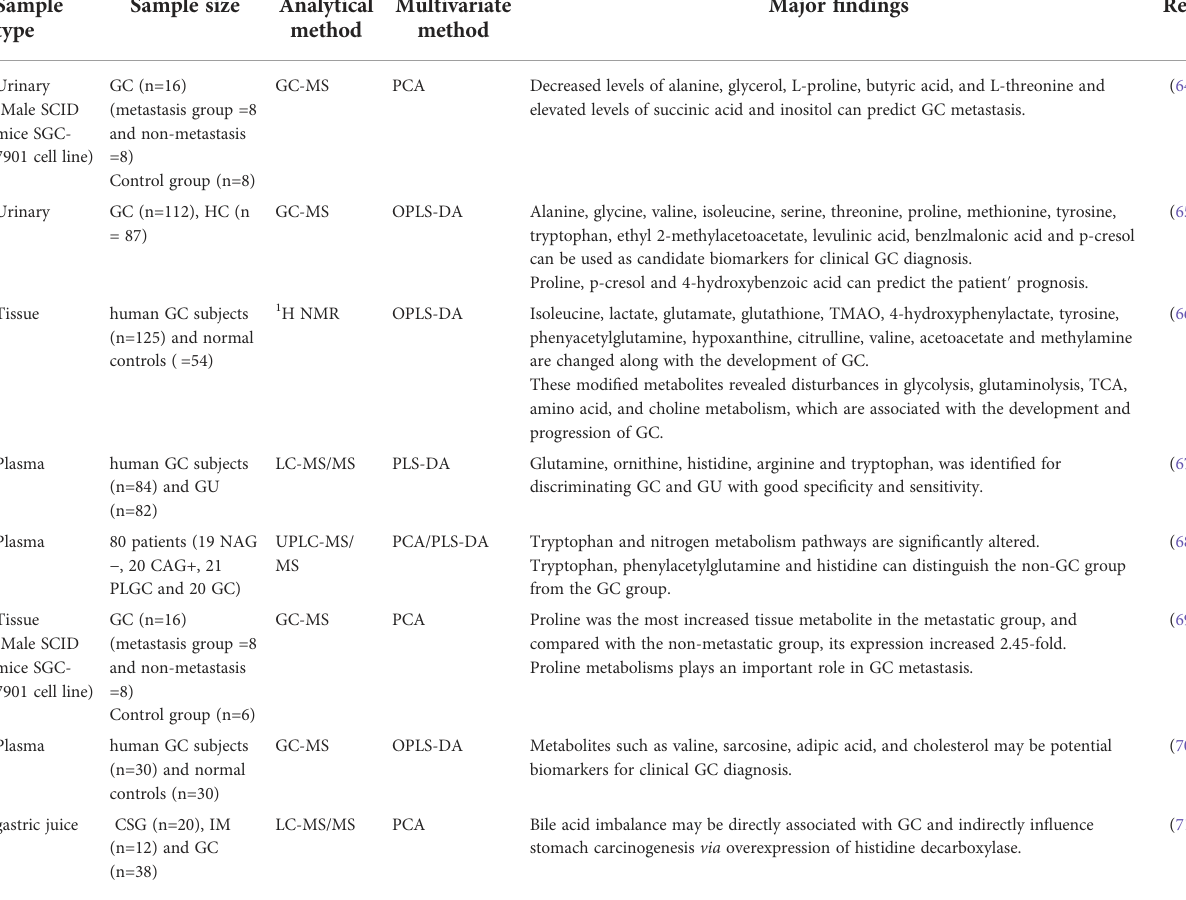
TABLE 2 Metabolic changes in gastric